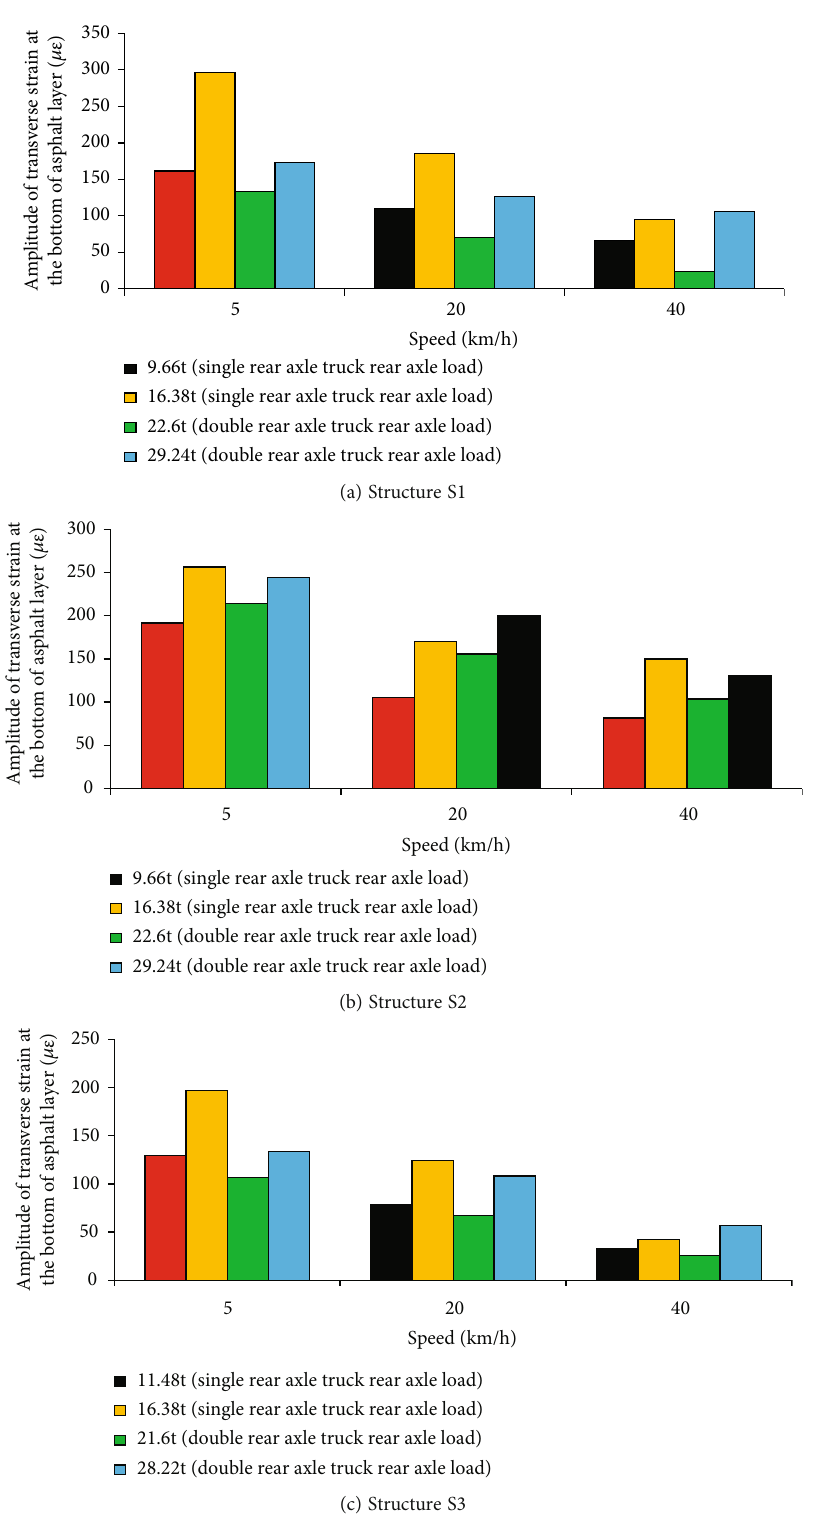
Figure 6: Relation between transverse strain amplitude at bottom of asphalt layer and axle